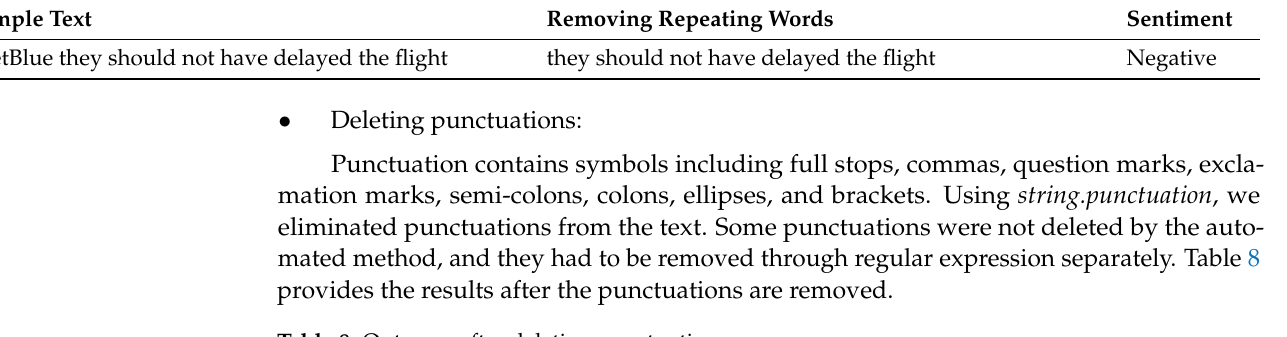
Table 8. Outcome after deleting punctuations.